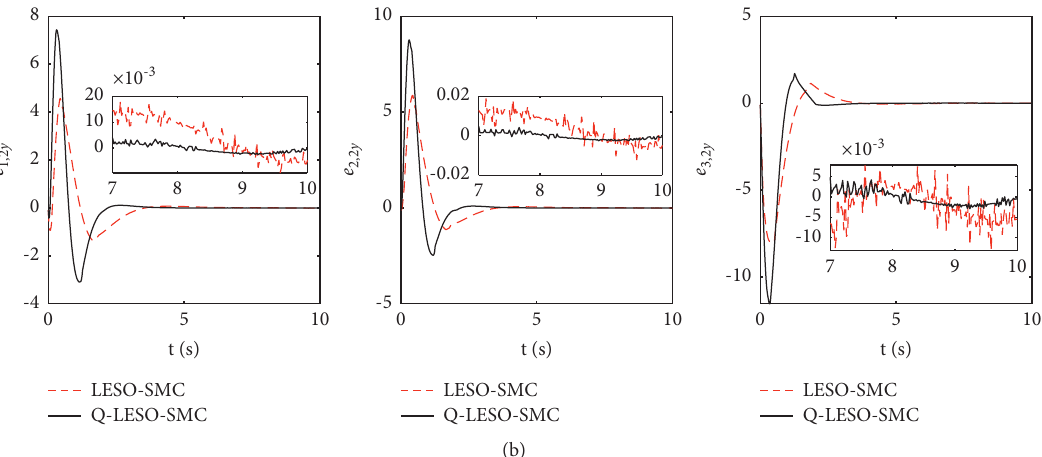
Figure 15: The formation tracking velocity error e i, 2 in Case B(a) The formation tracking velocity error of the x -direction of the i th agent i � 1, 2, 3. (b) The formation tracking velocity error of the y -direction of the i th agent i � 1, 2, 3.